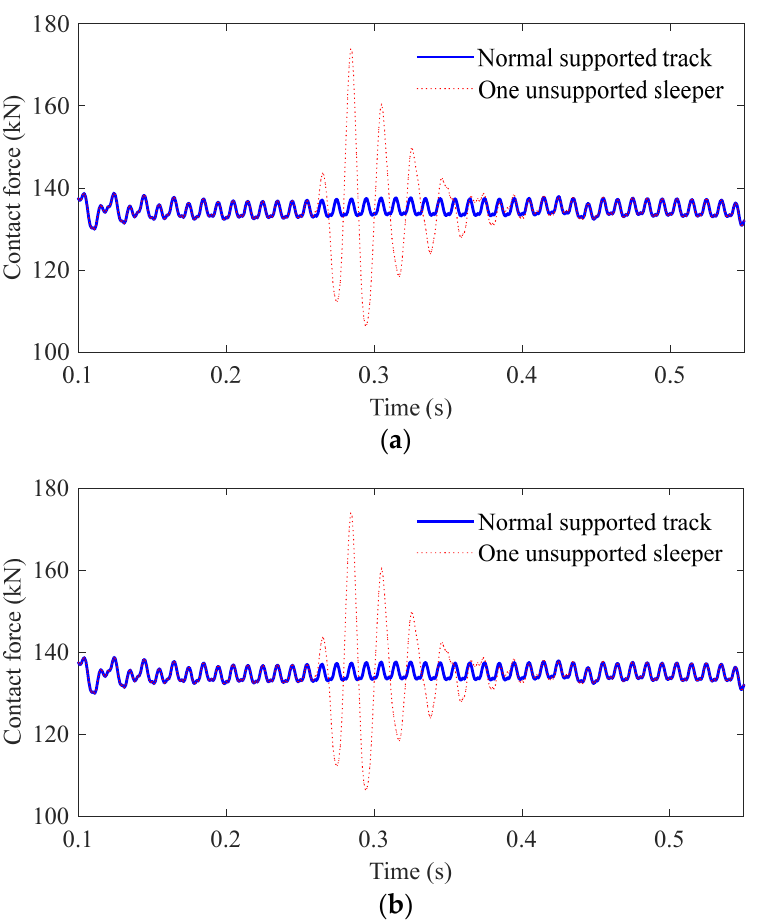
Figure 7. Wheel–rail vertical contact force under the bilateral unsupported sleeper at point B: ( a ) left side and ( b ) right side.